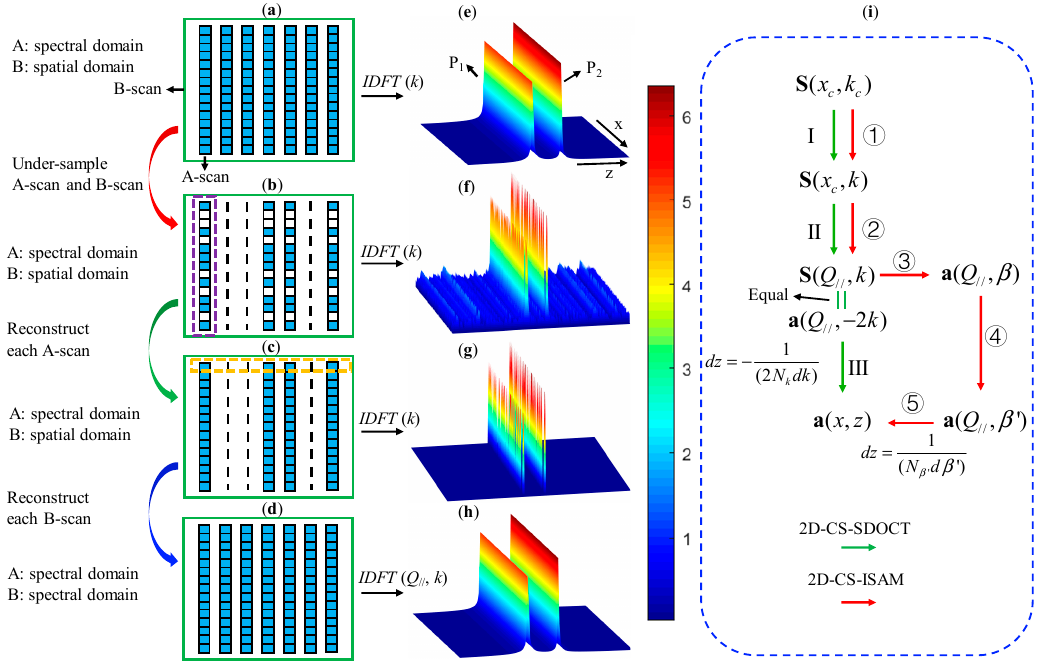
Figure 2. Schematic demonstration of the compressive sensing reconstruction strategy. ( a )–( d ) The patterns of the data matrixes, ( e )–( h ) the simulation results of two mirror surfaces, ( i ) processing steps of the method combining compressive sensing spectral domain optical coherence tomography (CS-SDOCT) and ISAM. In ( i ), β = − 2 k z (